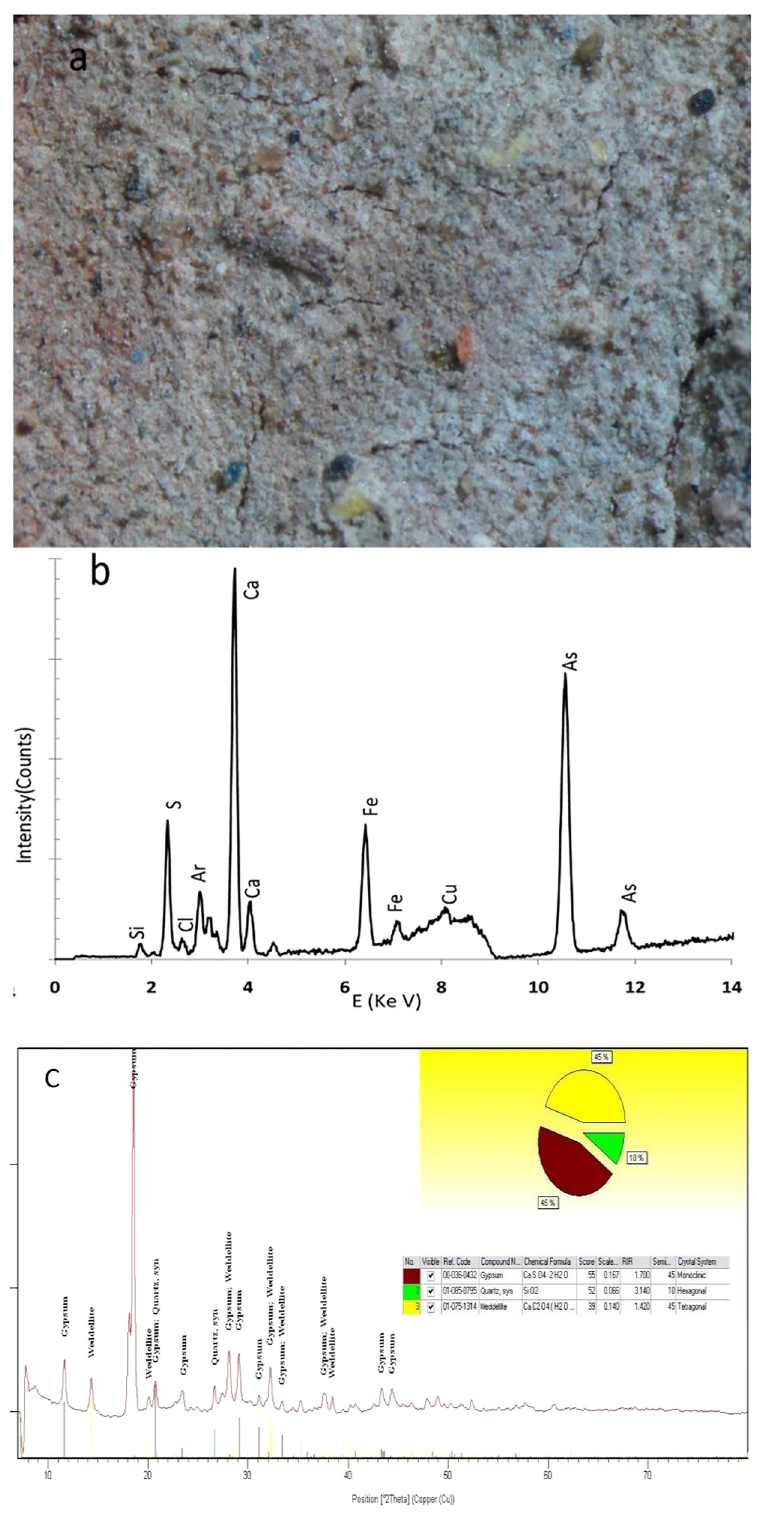
Figure 7: Characterization of the white painted layer ( Object GEM 3503 ) : ( a ) An optical micrograph; ( b ) XRF spectrum; and ( c ) XRD